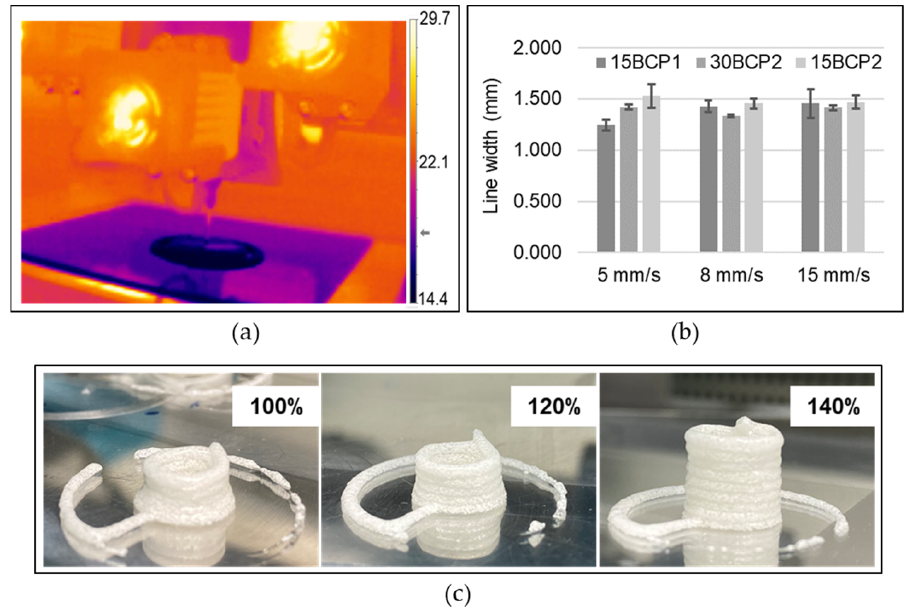
Figure 6. Printing set up. ( a ) Thermographic image of the temperature-induced in situ gelation of the inks. ( b ) Measured line width of filaments printed at 5, 8, and 15 mm/s. ( c ) Extrusion width calibration by printing hollow cylinders with different values of this process parameter.